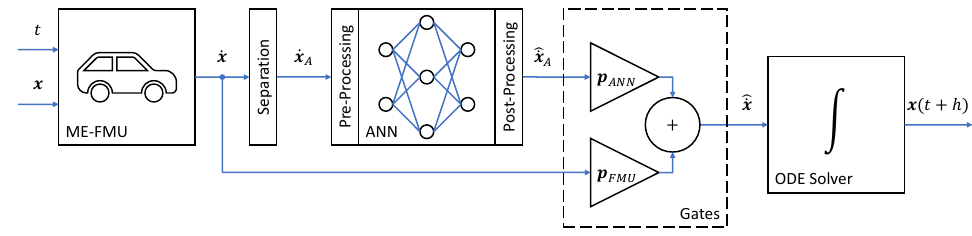
Figure 9. Topology of the used ME-NeuralFMU: The ME-FMU receives the current time t and state x from the numerical ODE solver and computes the corresponding state derivative ˙ x . The state derivative is then trimmed to a subset of derivatives ˙ x A . Before the ANN transforms ˙ x A , the signals are pre-processed to approximately fit a standard normal distribution. After the ANN’s inference, the inverse transformation of the pre-process is applied to the post-processed, and ˆ˙ x A is obtained. Two gates p ANN and p FMU scale how much ˆ˙ x A and ˙ x are introduced to the final derivative vector ˆ˙ x . Finally, the changed derivative vector ˆ˙ x is passed to the ODE solver with the (adaptive) step size h and integrated into the next system state x ( t + h ) . The used FMU has no continuous inputs u ; the driving cycle is part of the model and depends only on the time t .